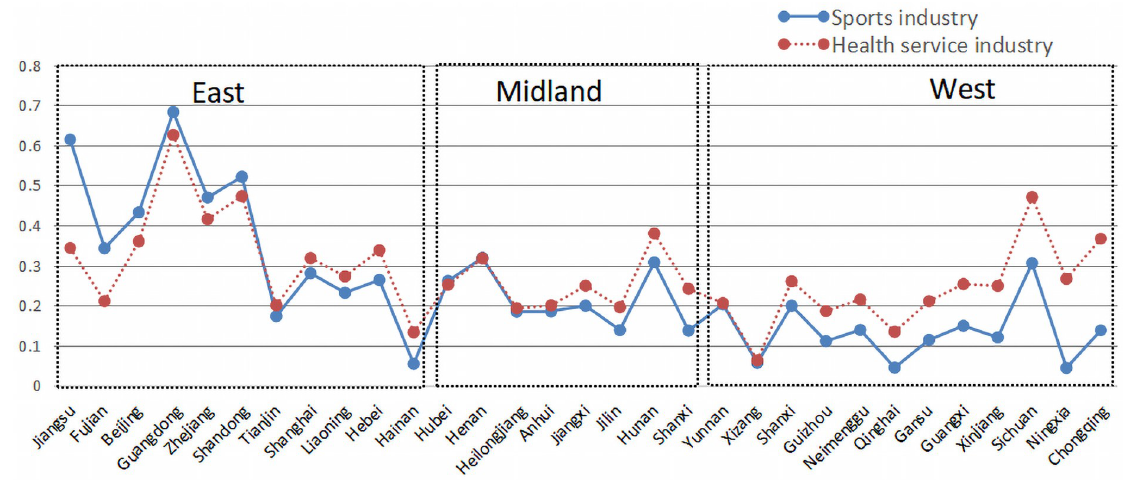
Fig 1. The development situation of comprehensive level of sports industry and health service